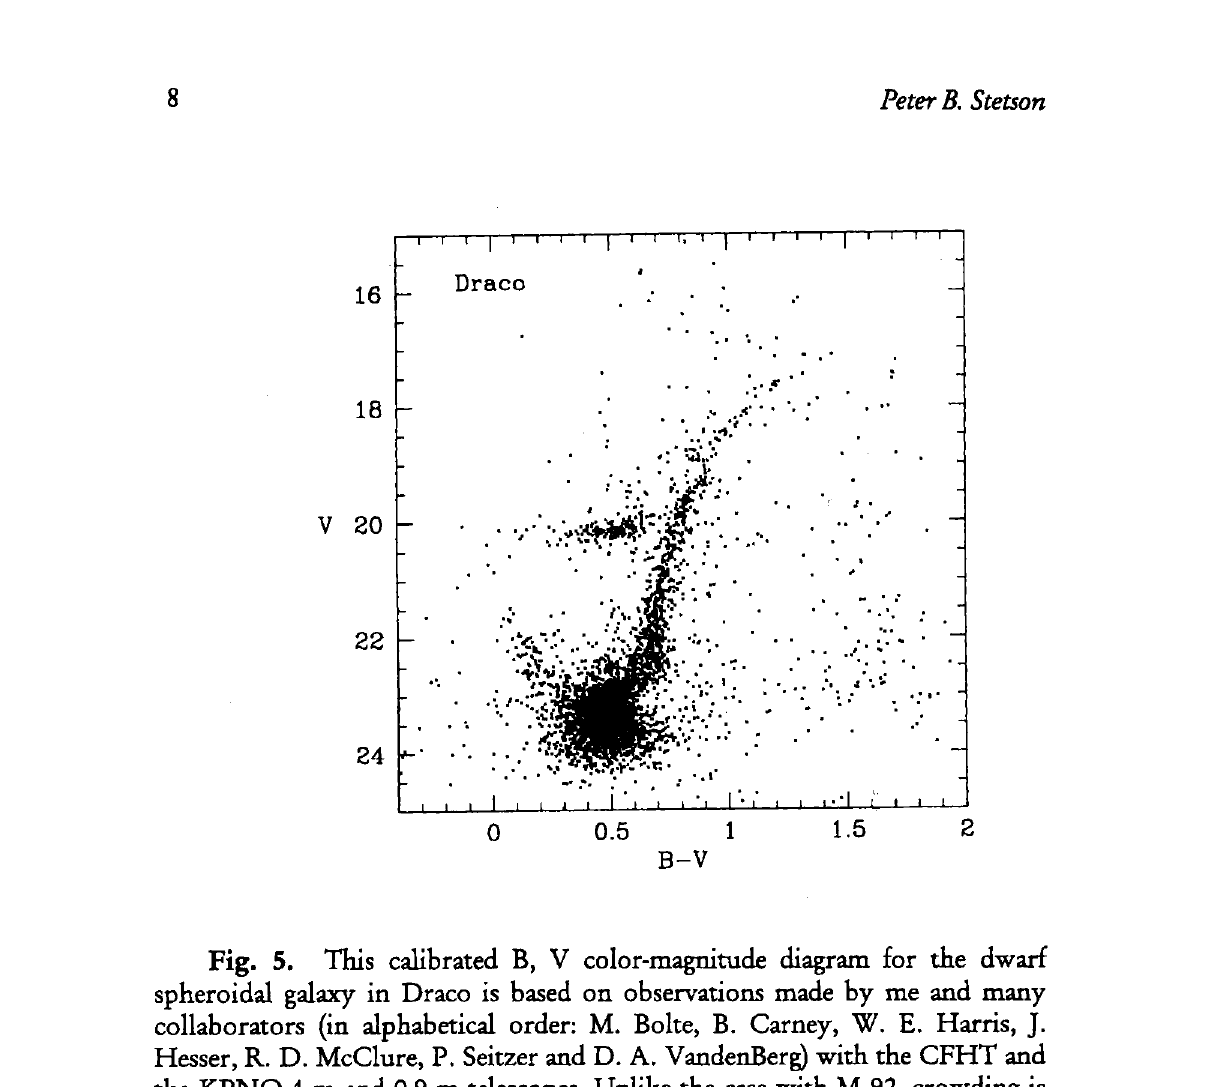
Fig. 5. This calibrated Β, V color-magnitude diagram for the dwarf spheroidal galaxy in Draco is based on observations made by me and many collaborators (in alphabetical order: M. Bolte, B. Carney, W. E. Harris, J. Hesser, R. D. McClure, P. Seitzer and D. A. VandenBerg) with the CFHT and the KPNO 4 m and 0.9 m telescopes. Unlike the case with Μ 92, crowding is not an issue here. Therefore it is quite possible that the semi-detached fringe of stars above the subgiant branch represents a secondary burst of star formation a Gyr or more after the primary burst. What of the stars extending brightward and blueward of the turnoff? Are they "ordinary" blue stragglers, or could they represent a third (and fourth?) generation of stars? Note that there are a number of stars lying above the red end of the horizontal branch, just where the core helium-burning members of this seemingly younger population would be expected to